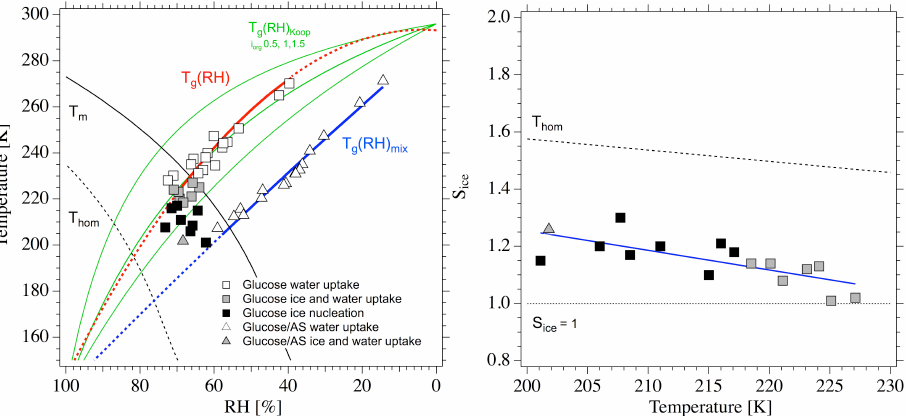
Fig. 3. State diagram and corresponding S ice plot for all experiments in which glucose or glucose/ammonium sulfate was investigated. Other symbols, lines and notation are the same as in Fig. 2. Glucose T g (RH) Koop curves (green) were calculated using T g (dry) = 296.1K and k GT = 3 . 95 for van’t Hoff factors ( i org ) 0.5, 1 and